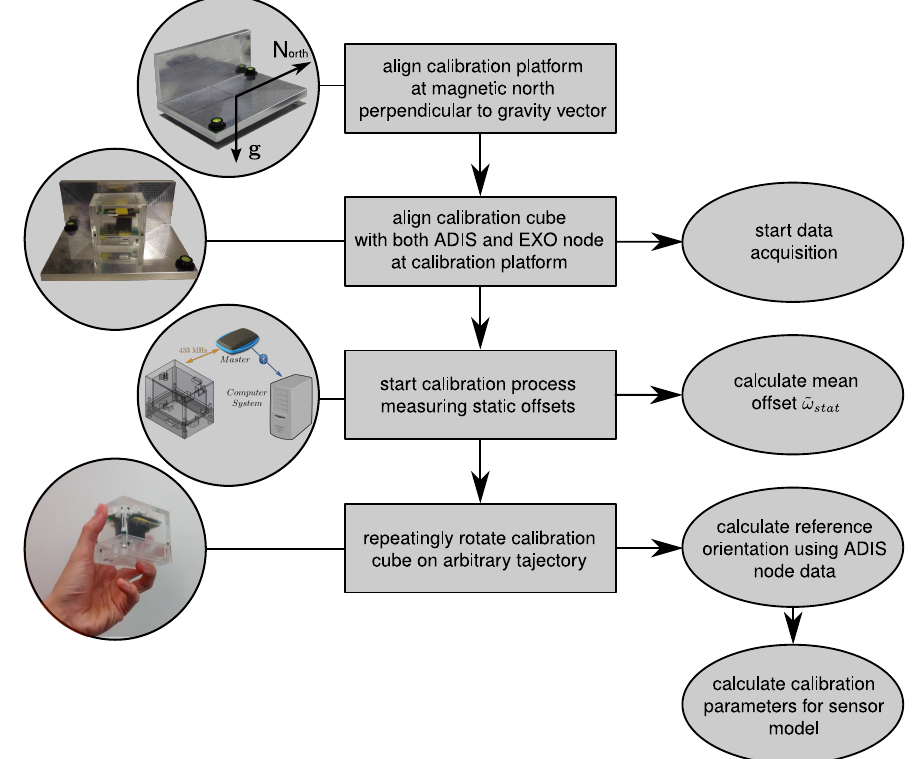
Figure 1. Overview of the calibration procedure with users actions depicted in rectangular boxes and algorithm parts in